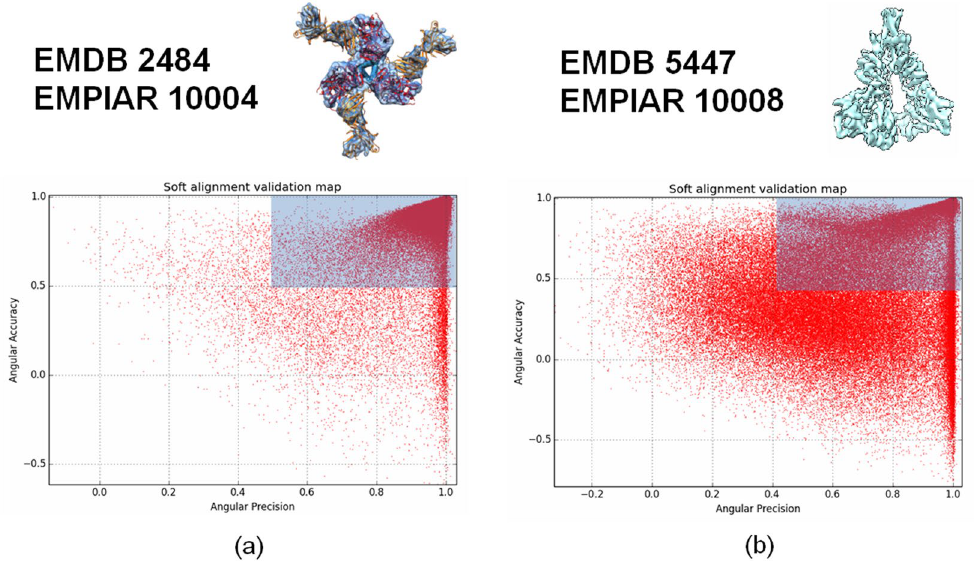
Figure 10. Resultant soft-alignment validation plots for HIV-1 trimmer reconstructions with EMDB codes 2484 ( a ) and 5447 ( b ) and using the deposited particles in EMPIAR with codes 10004 (88,125 particles) and 10008 (124,478 particles), respectively.